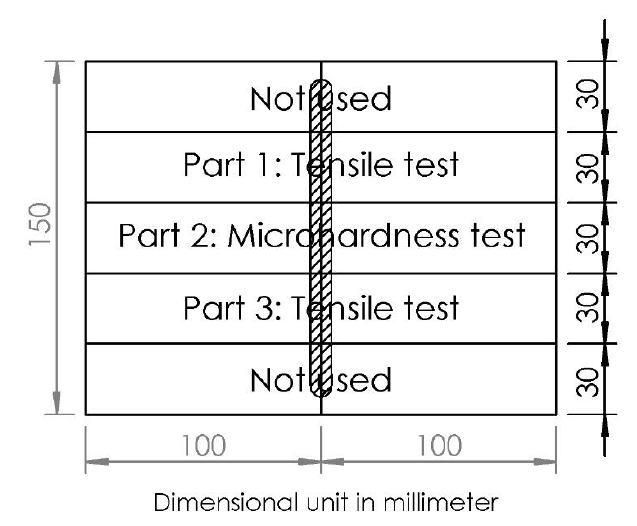
Figure 4. Separation of welded workpieces.